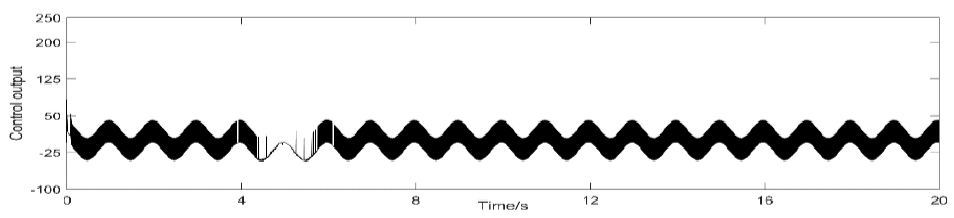
Figure 16. Standard sliding mode controller output.